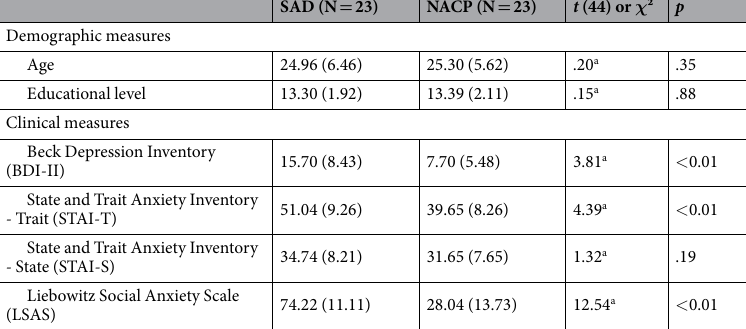
Table 1. Demographic and clinical measures for patients qualifying for the DSM-5 diagnosis of social anxiety disorder (SAD) and matched nonanxious control participants (NACP): mean ( SD ). Note. Education level was assessed according to the number of years of education completed after starting primary